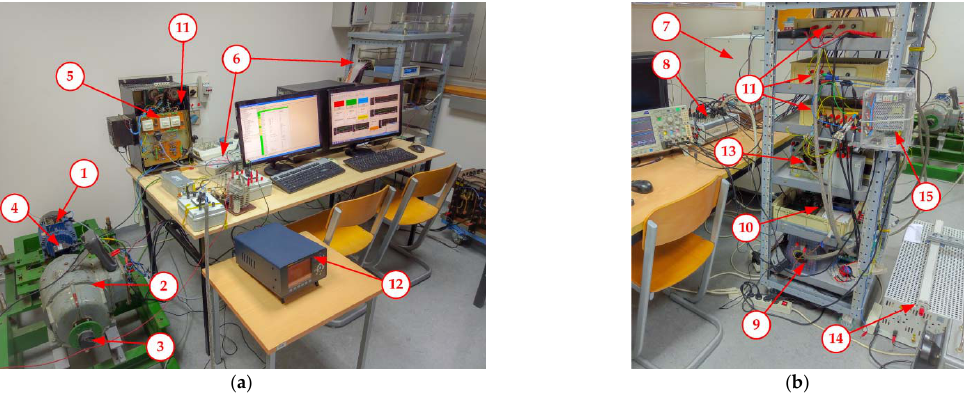
Figure 6. Laboratory setup of the considered WECS: ( a ) WT SCIG part of the setup; ( b ) qZSI part of the setup. During the experimental testing, the switching frequency of the qZSI was set to 5 kHz, whereas the switching frequency of the IGBT bridge rectifier was variable due to the